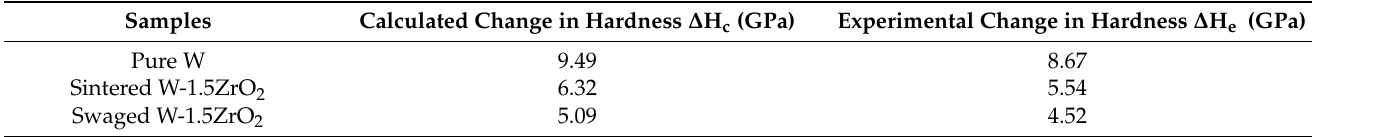
Table 1. The comparison between the calculated hardness changes ∆ H c and the experimentally obtained hardness changes ∆ H e for the three irradiated W-based